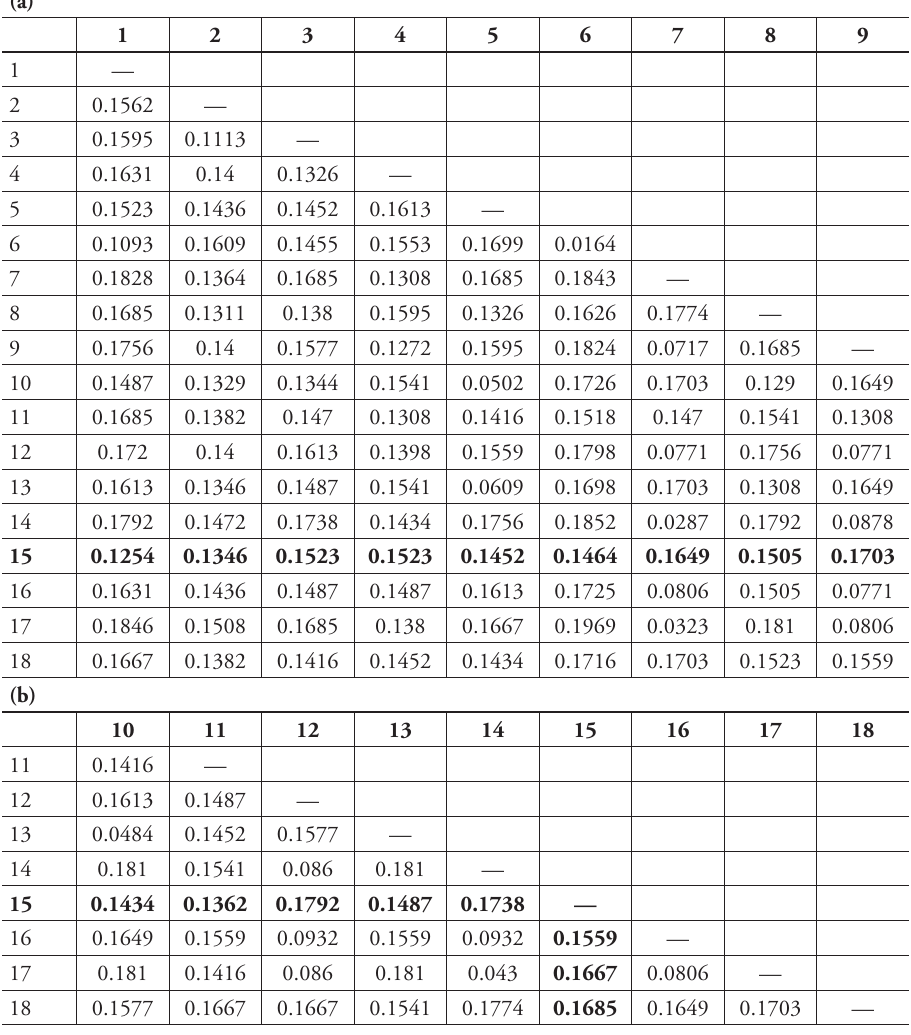
Table 2. The pairwise uncorrected p -distance (%) of the COI partial sequence used in this study (a, b). 1: Rana amurensis ; 2: R. asiatica ; 3. R. arvalis ; 4: R. chaochiaoensis ; 5: R. chensinensis ; 6: R. coreana ; 7: R. culaiensis ; 8: R. dybowskii ; 9: R. hanluica ; 10: R. huanrensis ; 11: R. japonica ; 12: R. jiemuxiensis ; 13: R. kukunoris ; 14: R. longicrus ; 15: R. luanchuanensis sp. n.; 16: R. omeimontis ; 17: R. zhenhaiensis ; and 18: